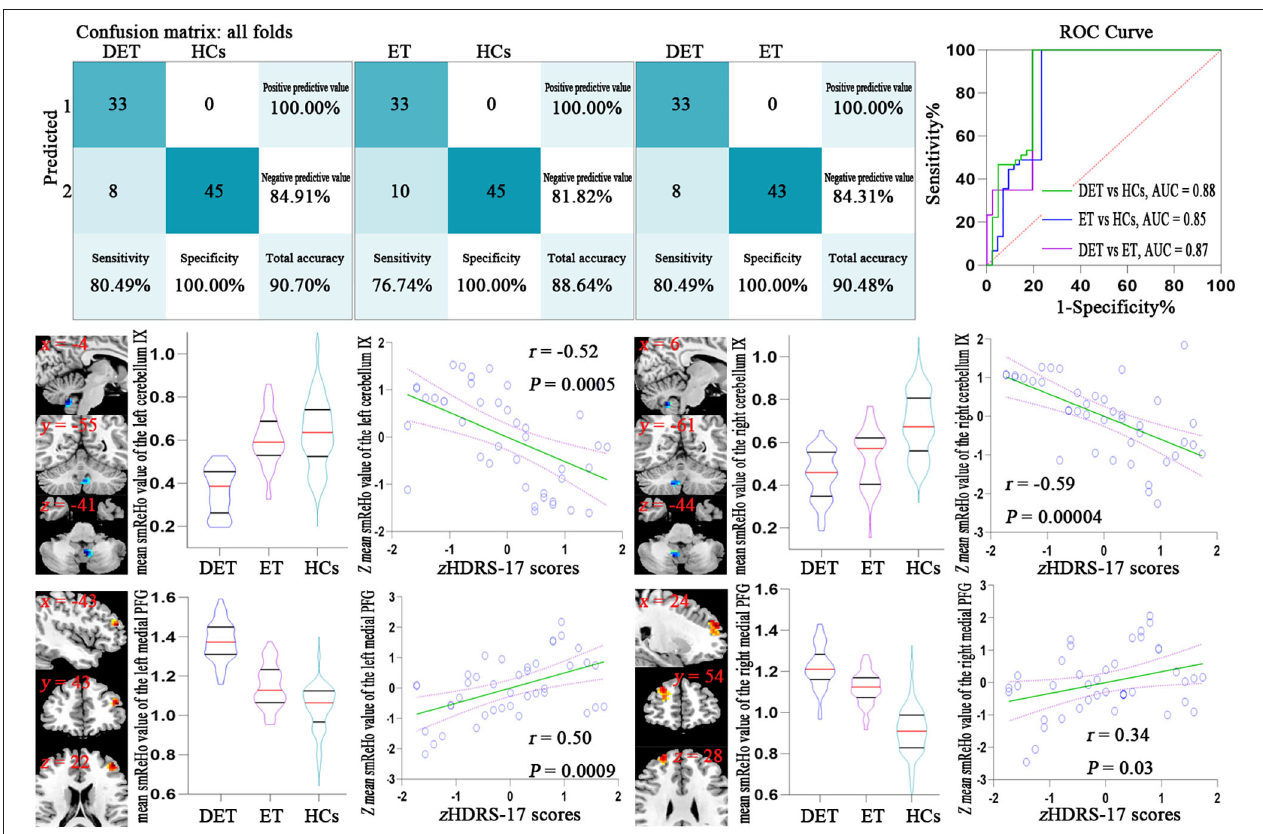
FIGURE 1 | Confusion matrix and ROC curve of the binary SVM algorithm (upper pictures). Correlation analysis results between the smReHo values of significant discriminative features and the HDRS-17 scores in depressed ET patients (lower pictures). Bonferroni multiple comparison corrections, corrected p < 0.05/18*(18-1)/2. smReHo, smoothed regional homogeneity; PFG, prefrontal gyrus; zHDRS-17 scores, z-transformed Hamilton Depression Rating Scale 17-item scores; DET, depressed essential tremor; ET, non-depressed essential tremor; HCs, healthy controls; ROC, receiver operating characteristic; AUC, area under the